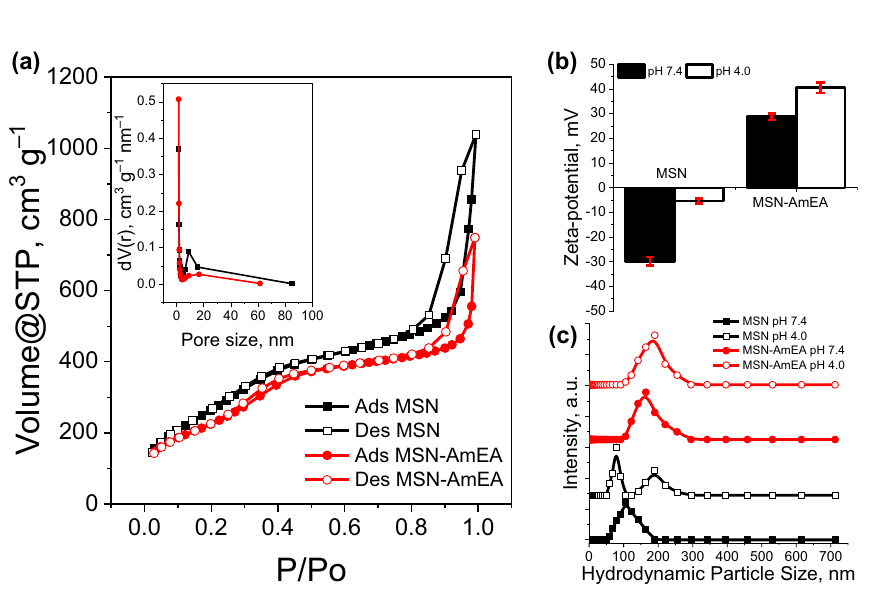
Figure 4. ( a ) N 2 adsorption–desorption isotherm (inserted box represented the pore size distribution), ( b ) zeta-potential, and ( c ) hydrodynamic particle size of MSN and